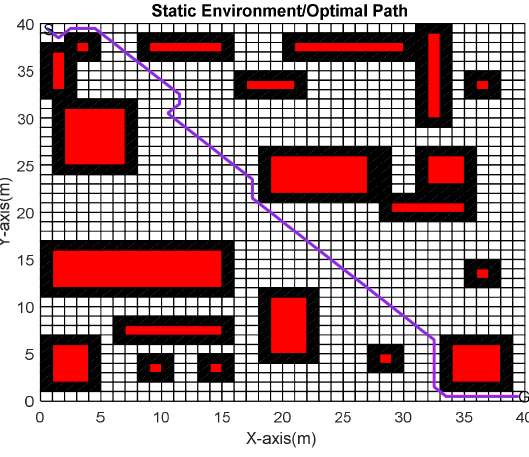
Fig. 16. Best Path found by Standard ACO